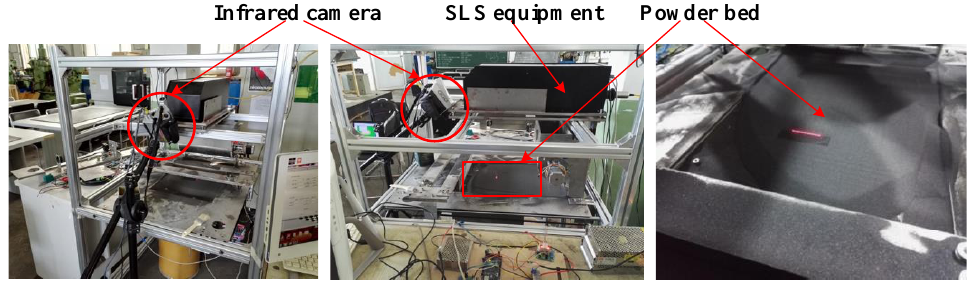
Figure 8. Experimental scene of selective laser sintering (SLS).